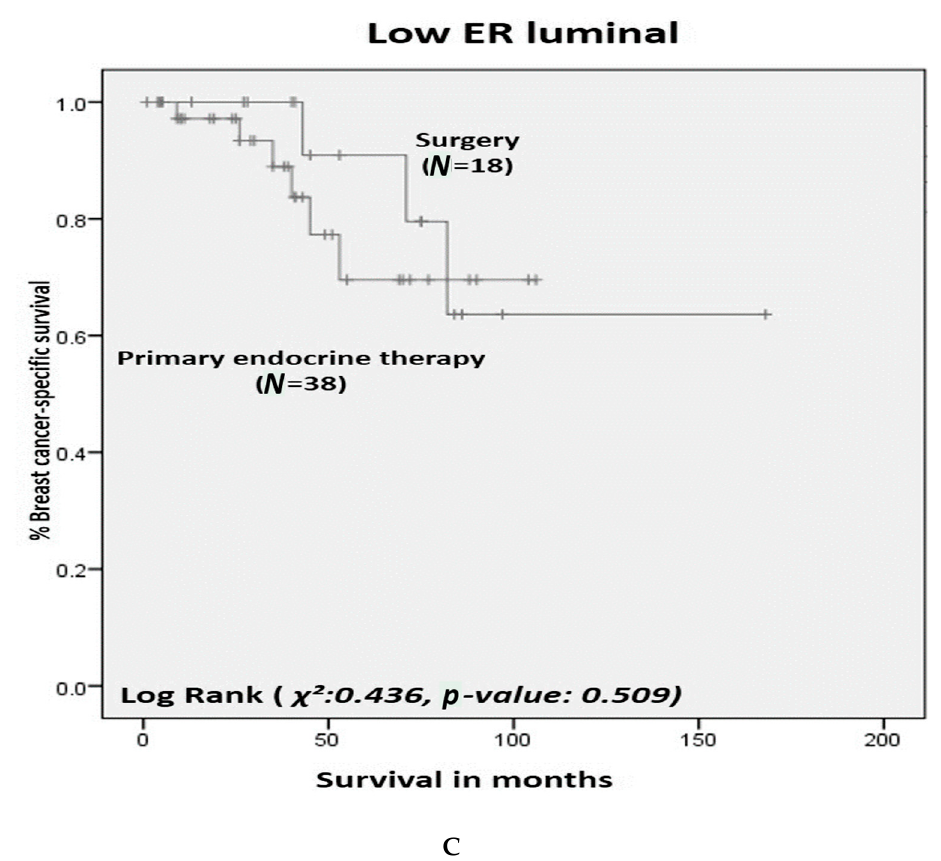
Figure 3. Older women with oestrogen receptor positive primary breast cancer: breast-cancer-specific survival of biological clusters ( A ) luminal A, ( B ) luminal B, and ( C ) Low-ER luminal according to surgery versus primary endocrine therapy.